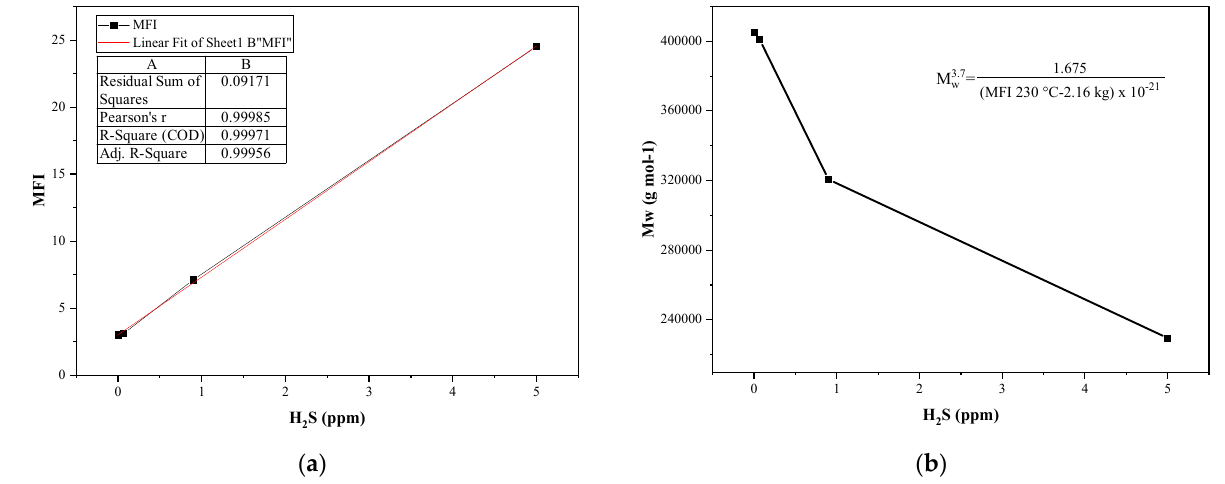
Figure 4. ( a ) The sample melt flow index (MFI); ( b ) the sample molecular weight (Mw).